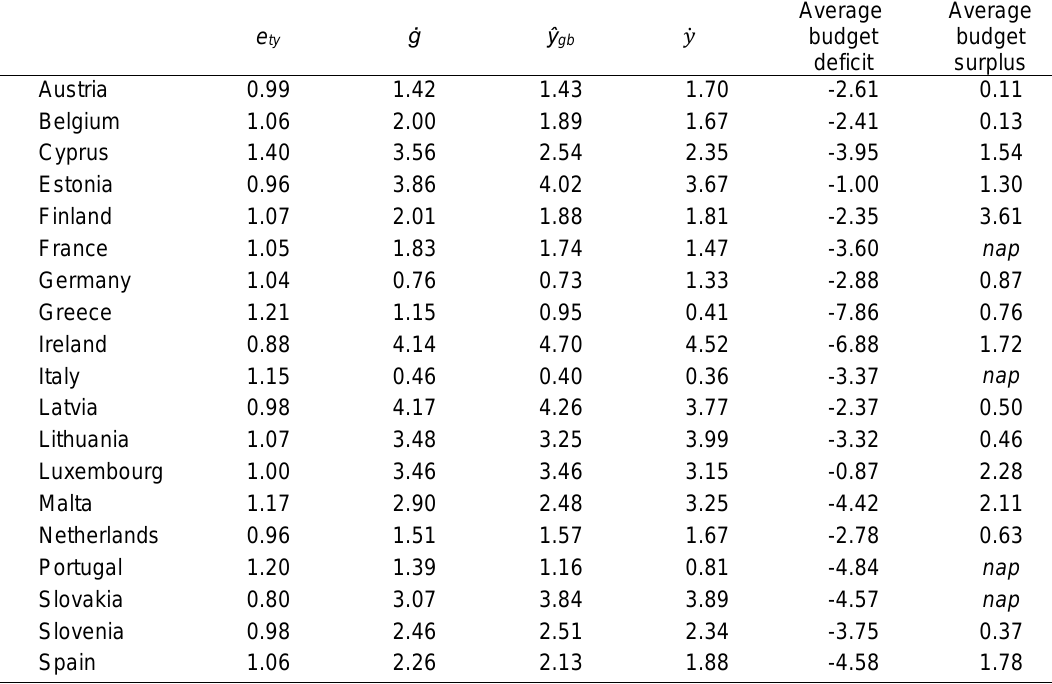
Table 1. Estimates of the government balance-consistent economic growth